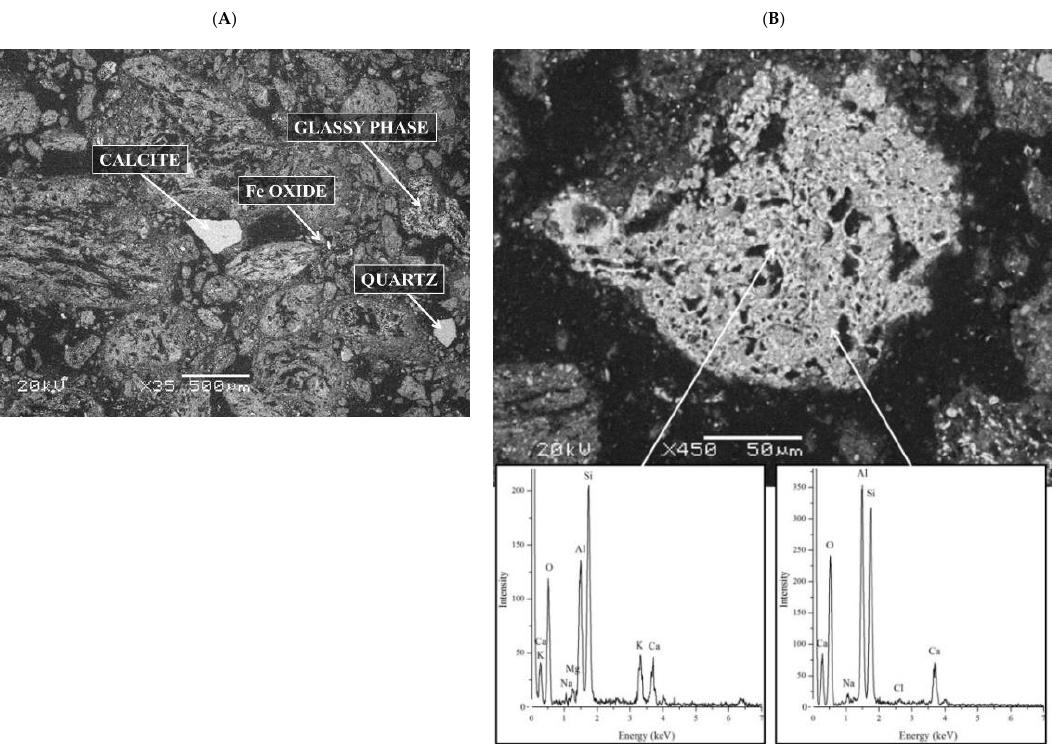
Figure 2. SEM micrographs of the paper ash; ( A ) showing the presence of different constituent phases; ( B ) the results of the semi-quantitative chemical analysis (EDS) of paper ash amorphous phase.